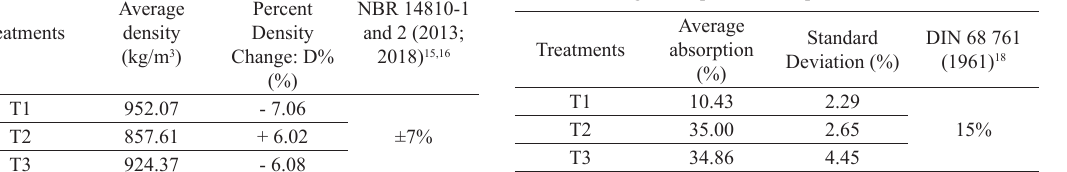
Table 5. Average absorption of the specimens